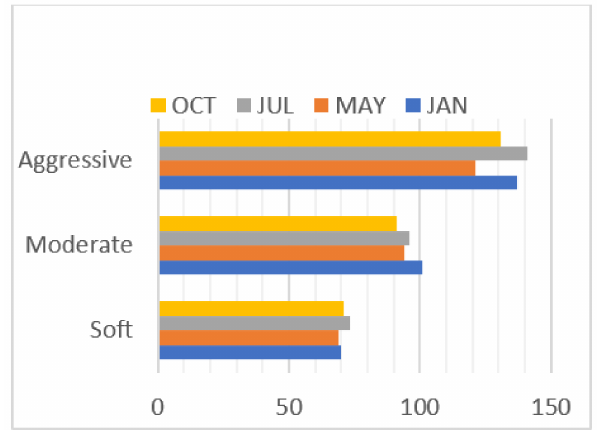
Figure 10. Number of Pursumers per month.